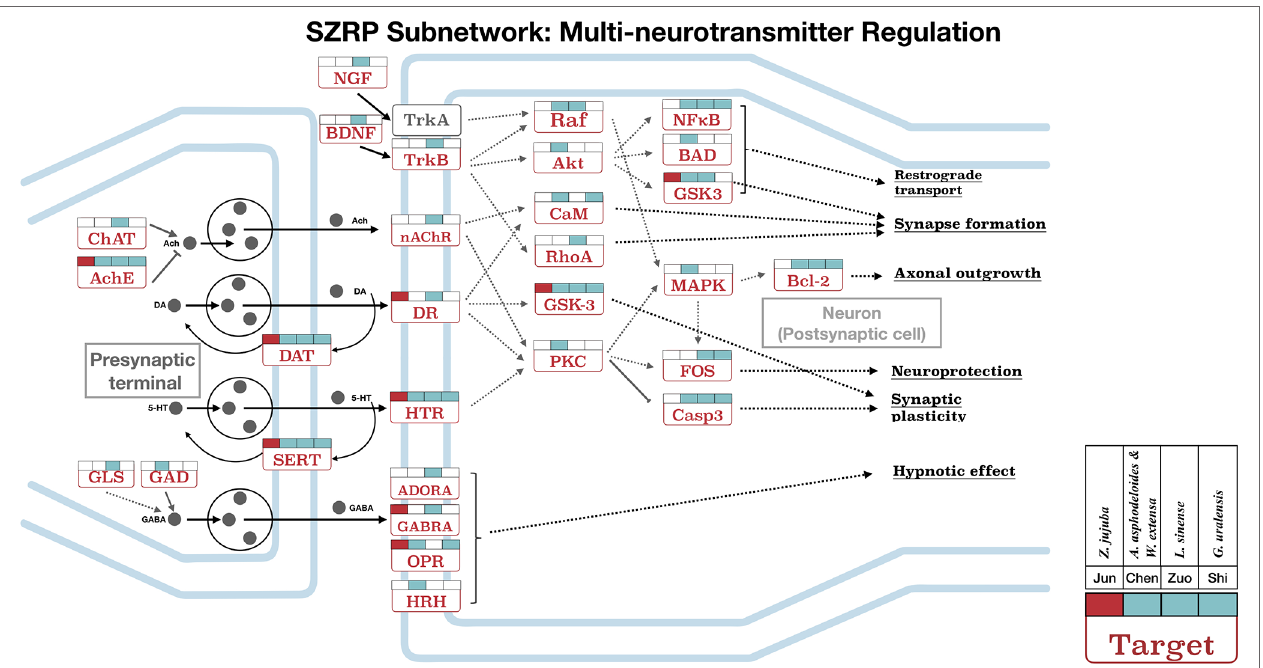
FIGURE 4 | The targeting subnetwork showing multi-neurotransmitter regulation at both pre-synapse and post-synapse for SZRP. Target names are shown in rectangles, and their full gene names can be found in Table S3 . The gray dots illustrate neurotransmitter/hormone. The colored flags above each target show the targeting pattern from four herbal groups of SZRP, where the Emperor ’s ( Jun ) targets are labeled in red. The solid arrows in the figure mean directed actions, and dashed arrows represent intermediate genes abbreviated for better